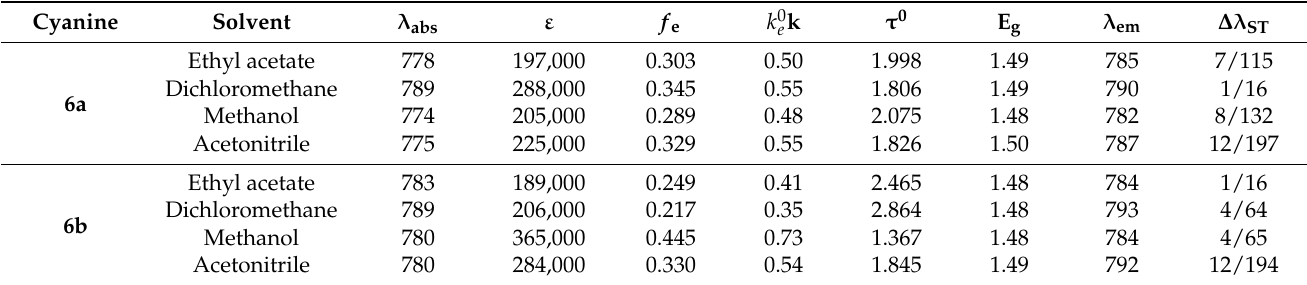
Figure 1. ( a ) UV-Vis absorption and ( b ) steady-state fluorescence emission spectra in solution of different organic solvents (~10 − 6 M) of the heptamethine cyanine dye 6a .